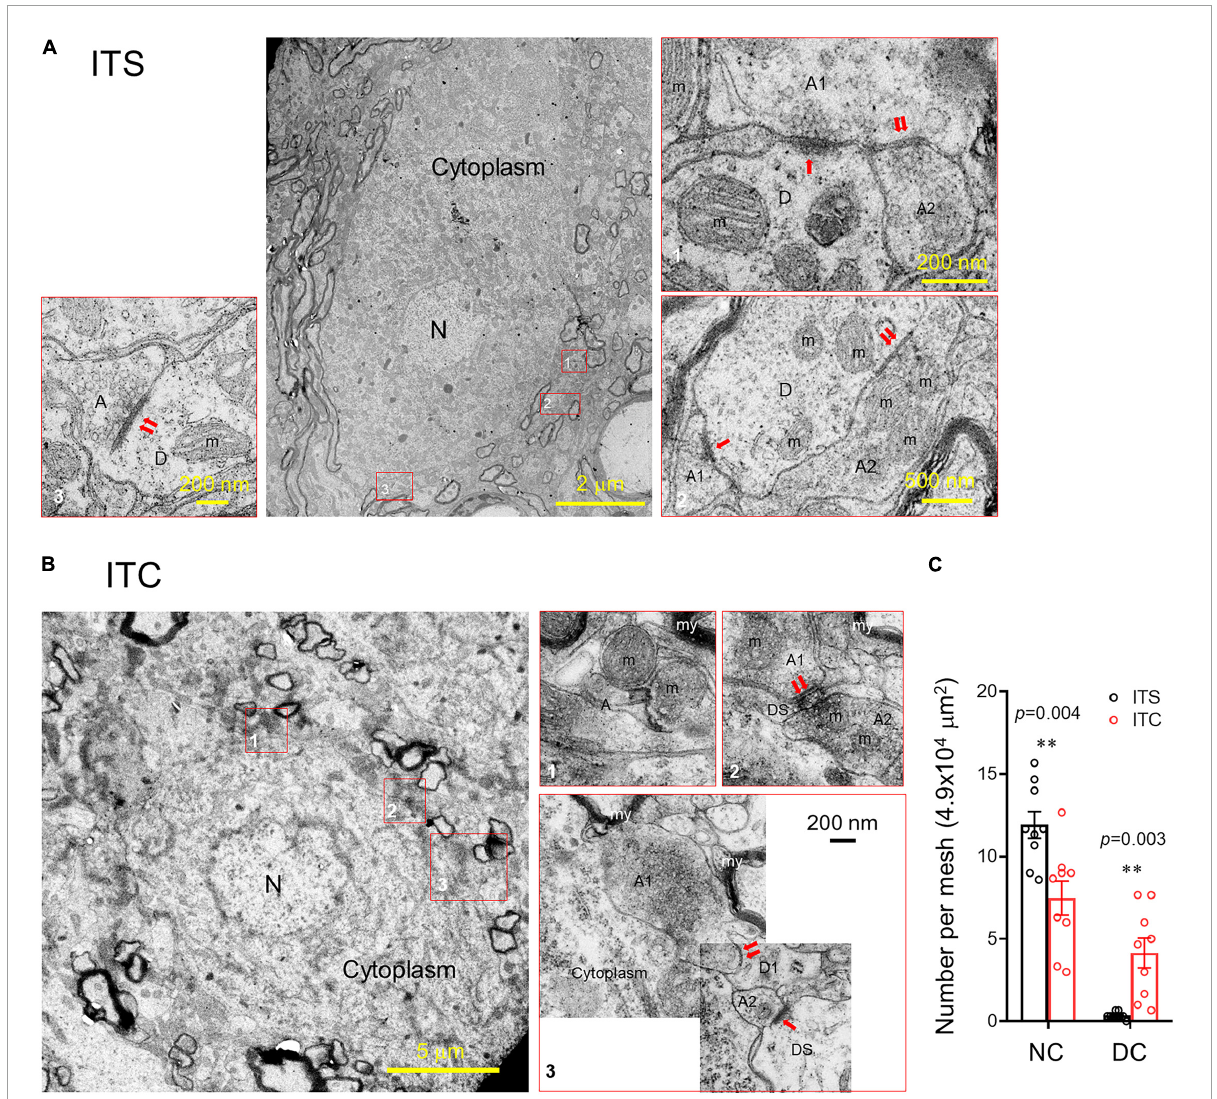
FIGURE5 Ultrastructural evidence for retrograde degeneration of spinal dorsal horn neuronal cell bodies and altered synaptic structures. (A) A normal neuronal cell body and adjacent synaptic structures 7 days after ITS. (B) A degenerating neuronal cell bodies with altered nucleus, damaged cell membranous structures and mitochondrial swelling, vesiculation, and disappearance of the crista and altered synaptic structures 7 days after ITC. A, axon; D, dendrite; DS, dendritic spine; m, mitochondrion; my, myelin; N, nucleus; ↑ asymmetric synapse; ↑↑ symmetric synapses. (C) Averaged number of normal neuronal cell bodies (NC) and degenerative neuronal cell bodies (DC) from the spinal dorsal horn following 7 days after ITC or ITS. ** p < 0.01, ITC vs. ITS, n = 3 rats/group, with nine ultrathin sections being observed and counted from each